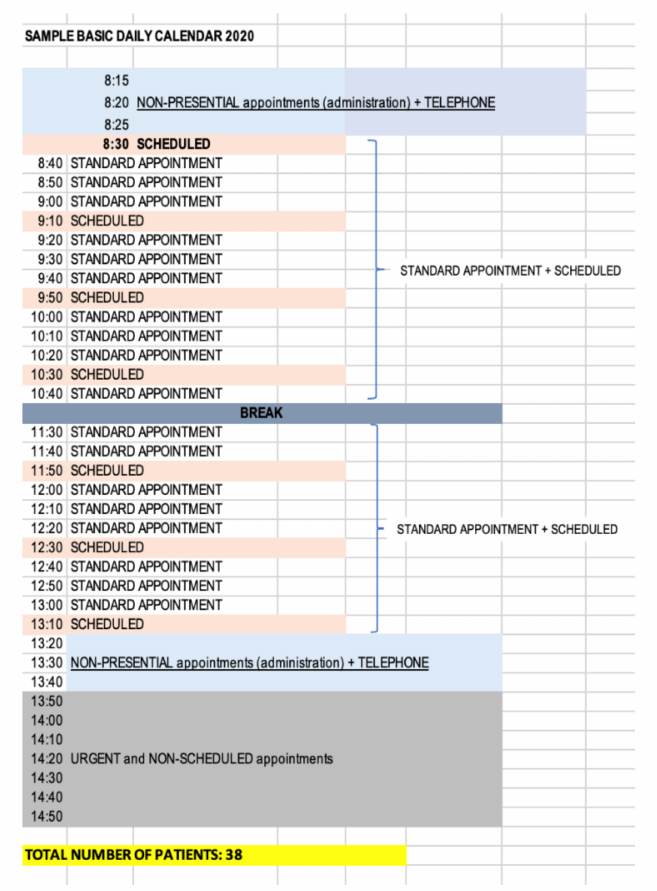
Figure 8. 2020 calendar.